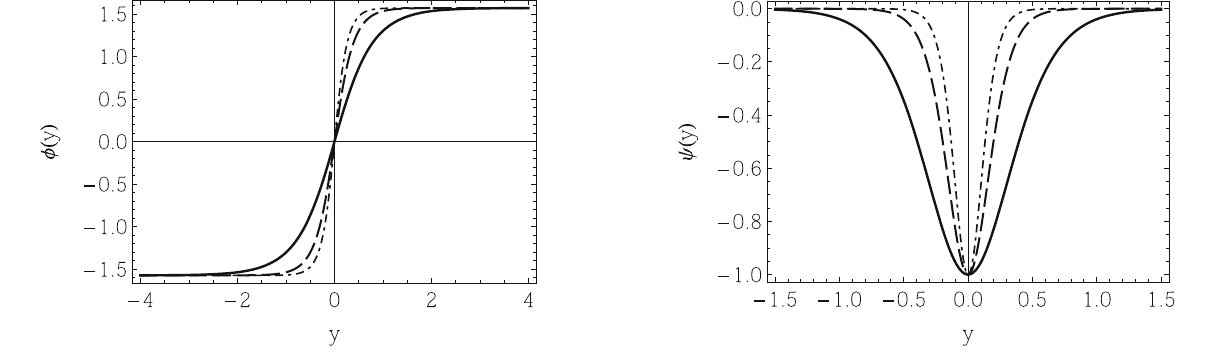
Fig. 1 Kink solution given by Eq. (24) for a = 1 (solid line), a = 2 (dashed line) and a = 3 (dot-dashed line)